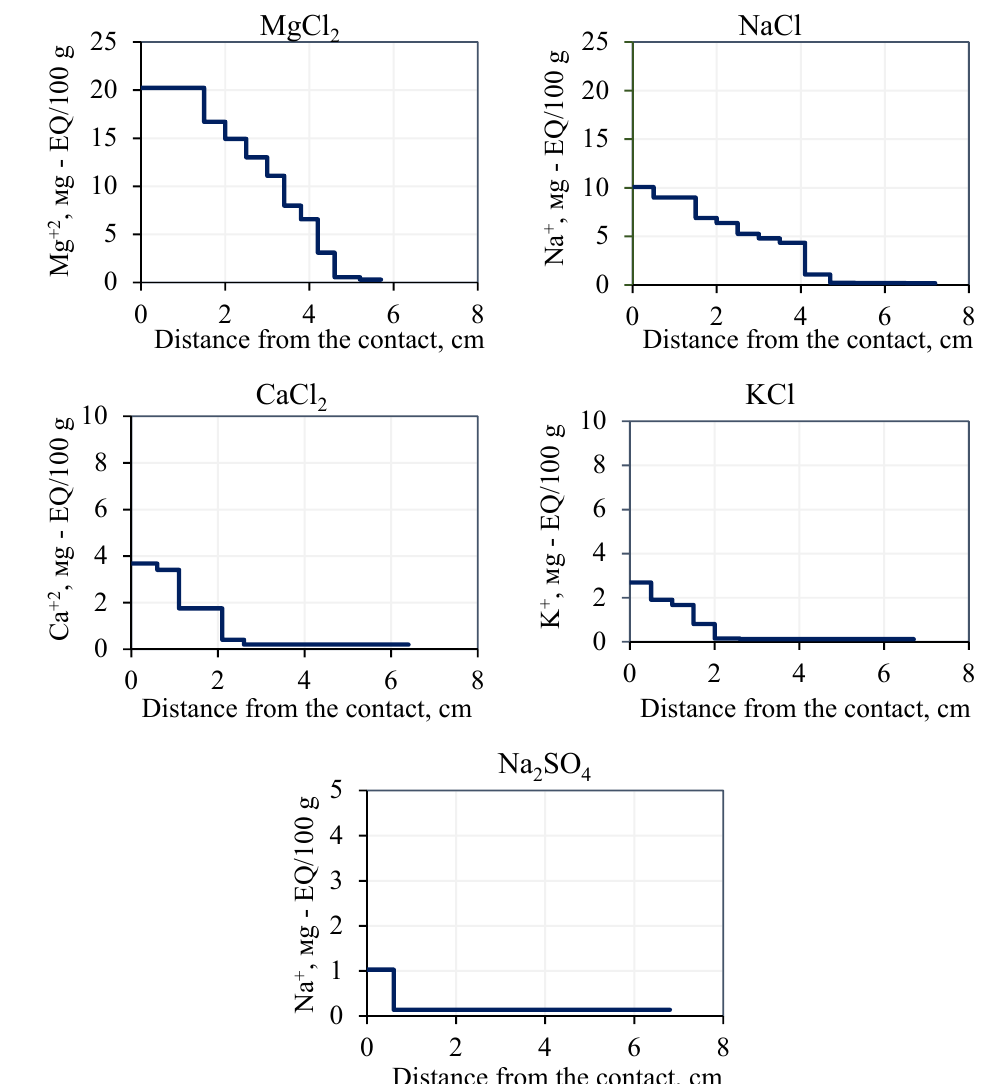
decrease within 3 cm (Figure